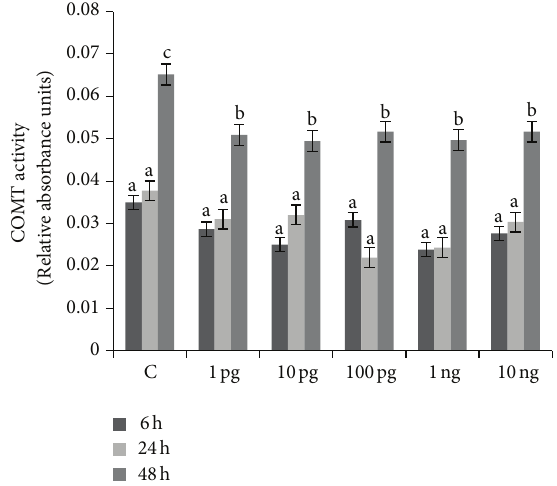
Figure 3: Time- and dose-dependent action of Halowax 1051 on COMT activity. Cocultures of granulose and theca cells were exposed to 1, 10, and 100 pg/mL and 1 or 10ng/mL of Halowax 1051. Statistically significant differences between points in graph are indicated with different letters; the same letters indicating no significant differences, with a < b.